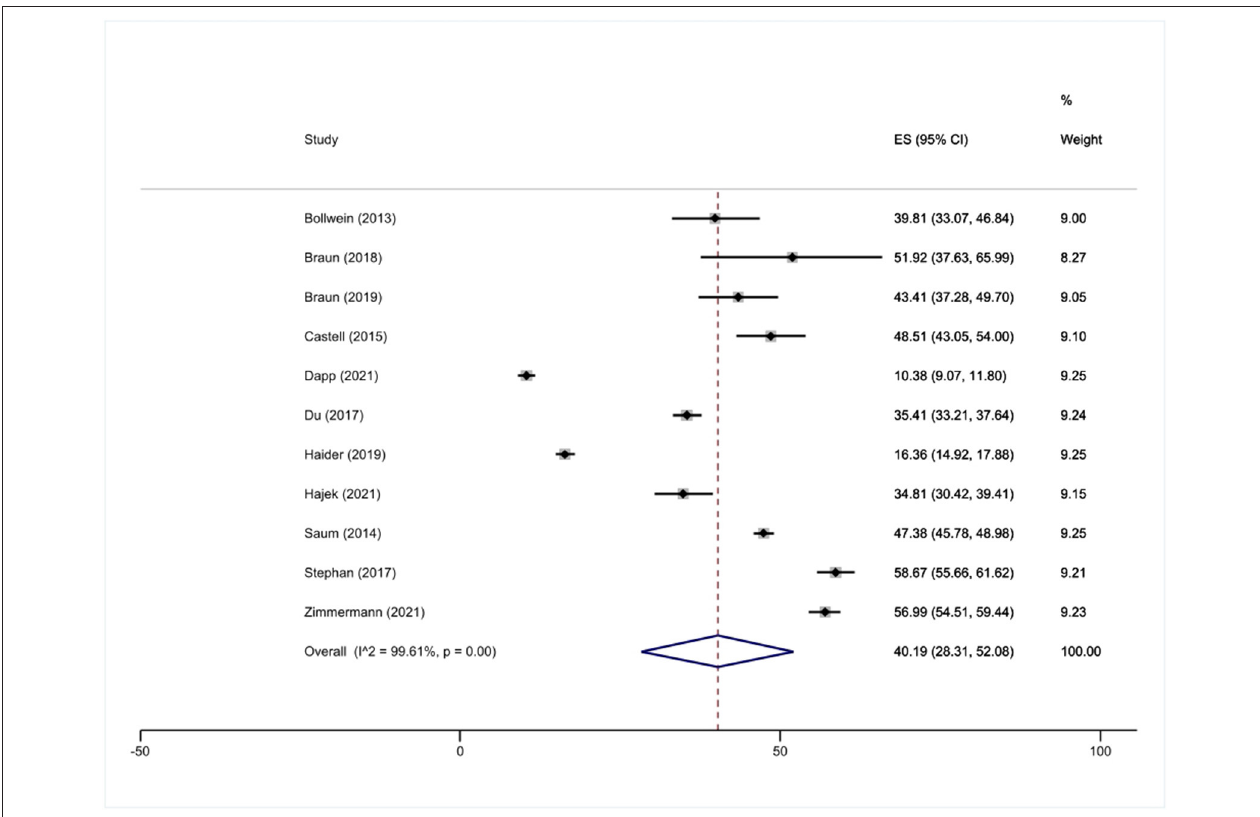
FIGURE 3 | Meta-analysis (prefrailty).